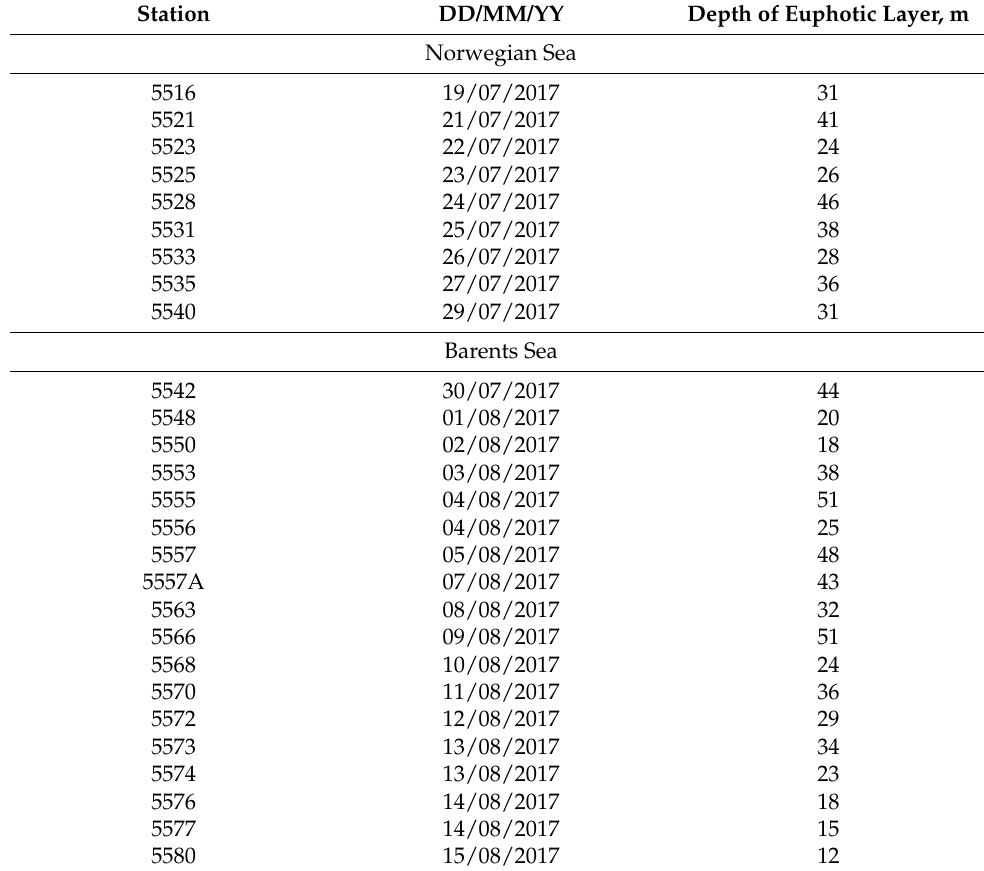
Table 2. Depth of euphotic layer (PAR 400–700 nm of 1%) at the stations in the Norwegian and Barents